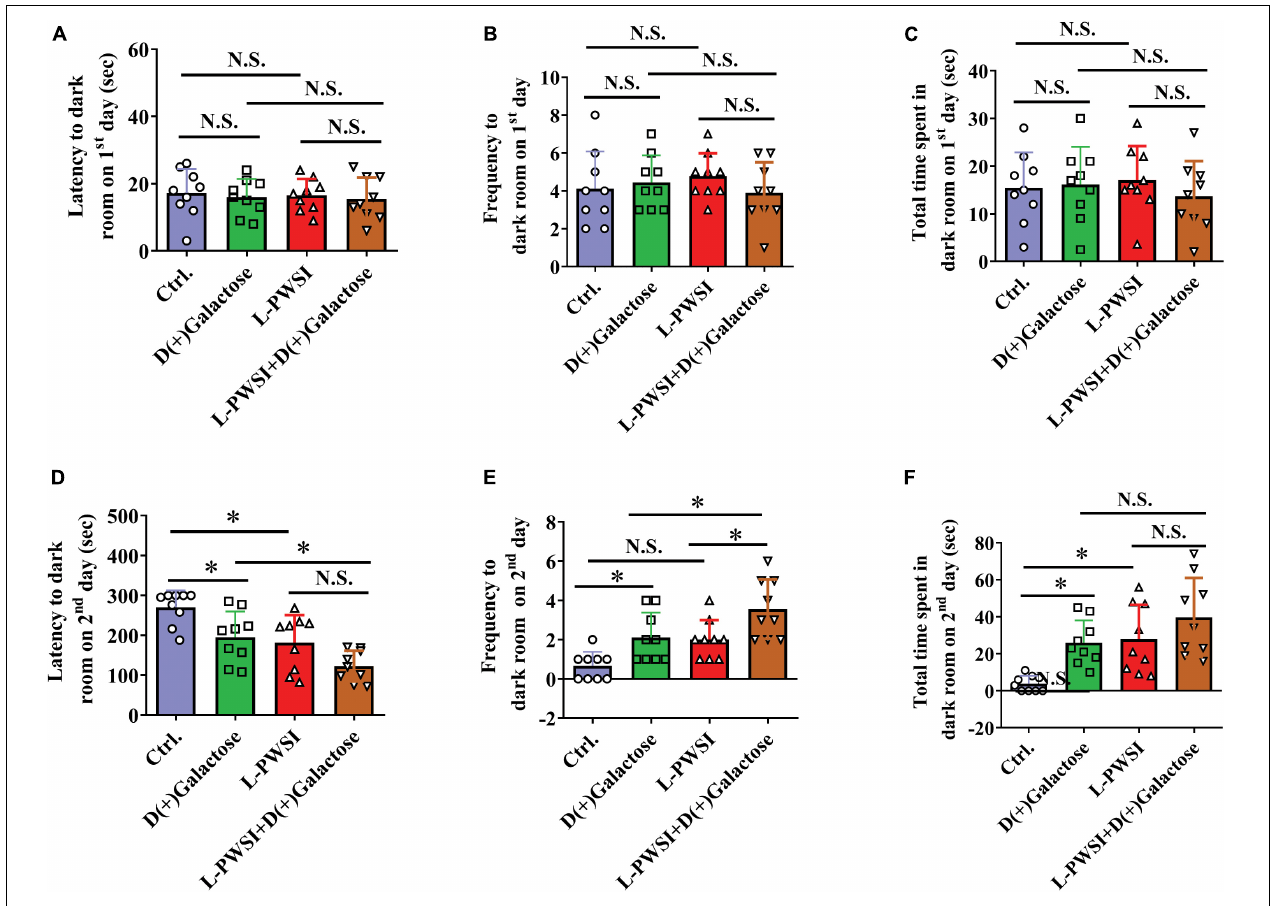
FIGURE 4 | Treatment with long-term post-weaned social isolation (L-PWSI) and D(+)Galactose affected escape learning behavior in PAT. The latency (A) , frequency (B) , and permanence time (C) to (in) the darkroom on the first day of PAT. The latency (D) , frequency (E) , and permanence time (F) to (in) the darkroom on the second day of PAT. Data are presented as the mean ± SEM. from 9 mice in each group. ∗ represents p < 0.05; N.S., represents no significance.